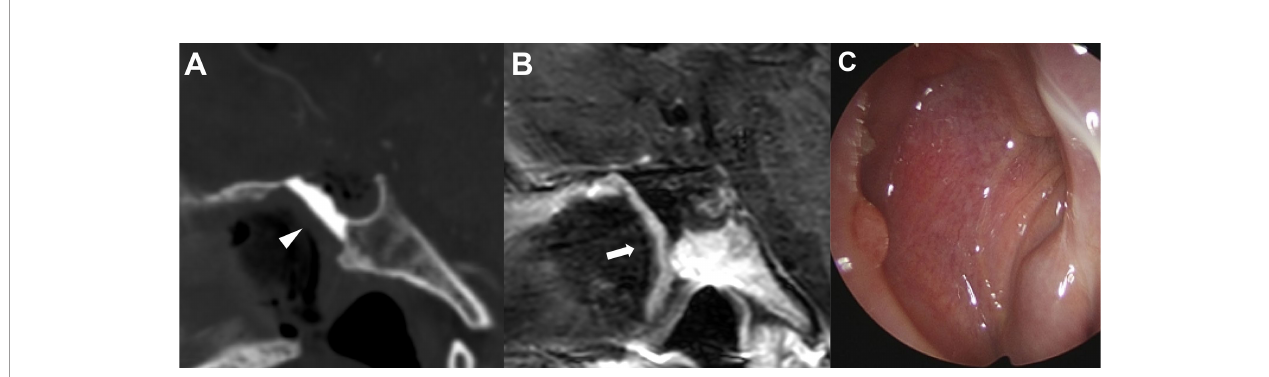
FIGURE 3 | Representative images of skull base reconstruction in endoscopic endonasal surgery of craniopharyngioma. (A) Postoperative sagittal computed tomography image of the operative area with hydroxyapatite in situ (arrowhead). (B) Postoperative sagittal magnetic resonance imaging with contrast enhancement indicating the integrity of vascularized naso-septal fl ap (arrow). (C) Complete sealing status of hydroxyapatite by the fl ap 3 months after surgery.